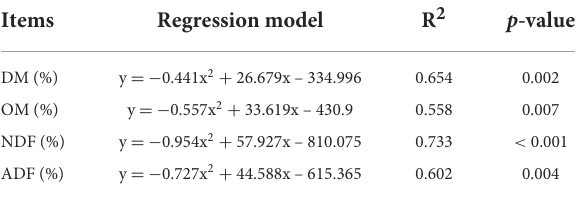
TABLE 4 Regression equations between dietary peNDF > 1.18 levels (x) and (y) ( n = 30, R 2 >